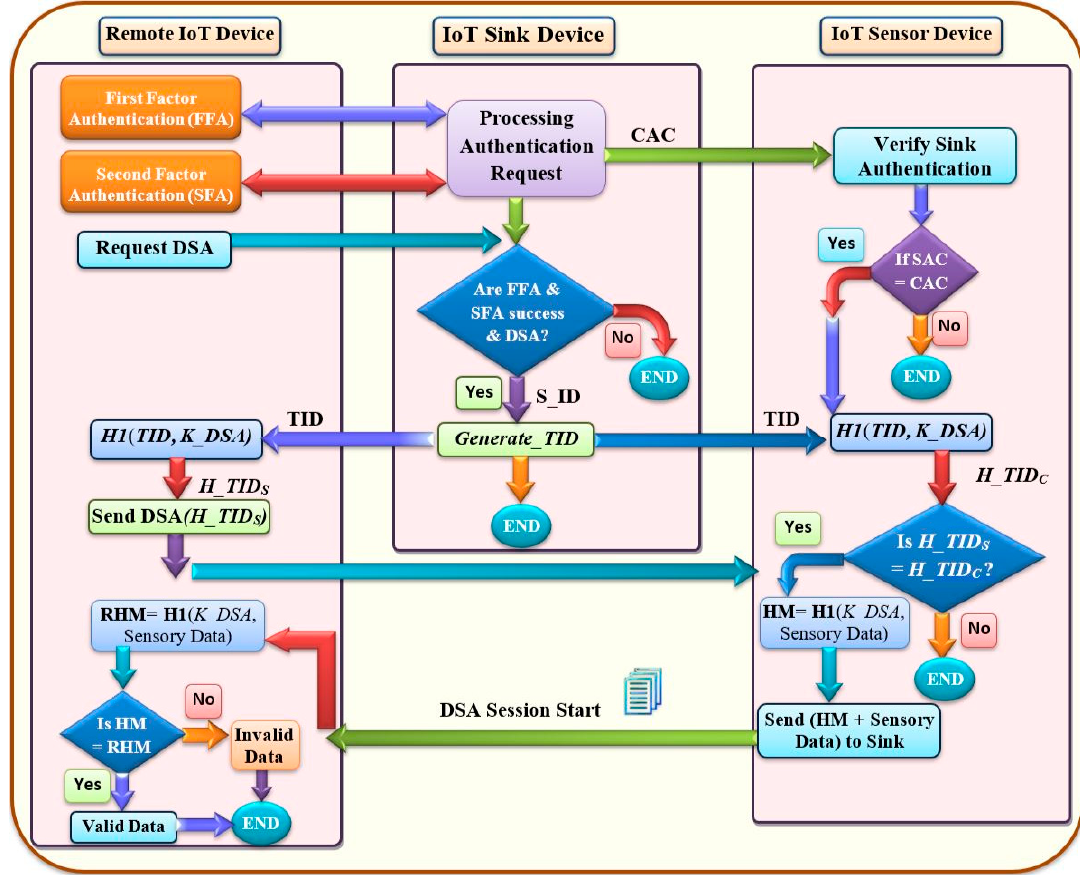
Figure 4. System design of micro–macro IoT authentication.